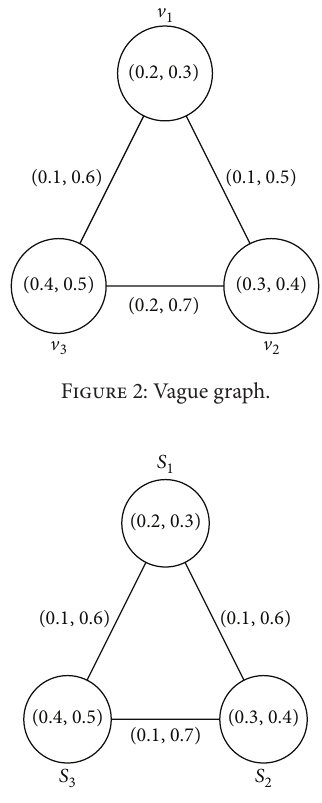
Figure 3: Vague intersection